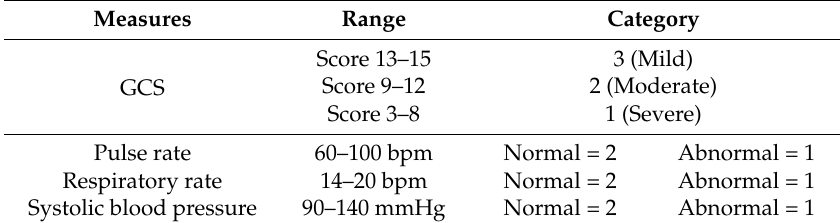
Table 5. Categorization of Glasgow coma score (GCS), pulse rate (PR, beats per minute, bpm), respiratory rate (RR, breaths per minute, bpm) and systolic blood pressure.